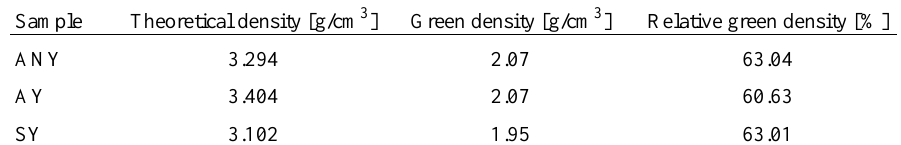
Table 2. Green density, theoretical density and relative green density of the compacted samples.